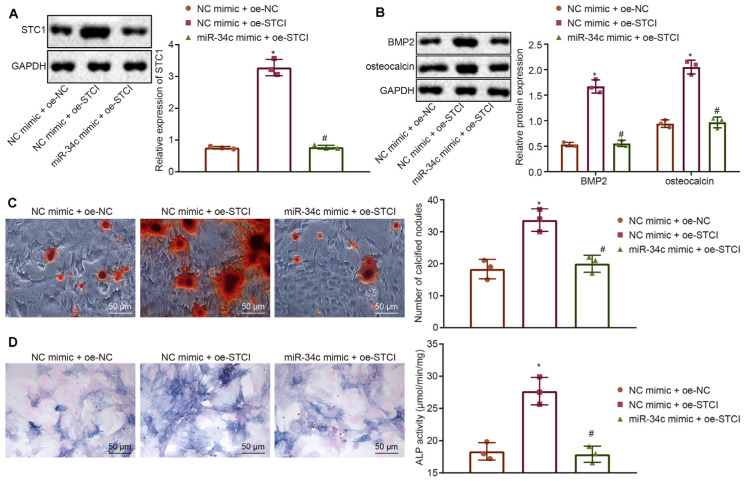
The osteogenic differentiation and calcification degree of VICs is inhibited by miR-34c via suppressing the expression of STC1. VICs were transfected with NC mimic + oe-NC plasmid; NC mimic + oe-STC1; and miR-34c mimic + oe-STC1, respectively. (A) The protein expression of STC1 in VICs with different treatment measured by western blot analysis. (B) The protein expression of BMP2 and osteocalcin determined by western blot analysis. (C) Alizarin red staining (×200) of calcification. (D) The staining figure of ALP (×200) and ALP quantitative activity analysis. Data were expressed as mean ± standard from at least three independent experiments. The comparison between two groups was checked by unpaired Student’s t test. *p < 0.05 vs. VICs transfected with NC mimic + oe-NC. #p < 0.05 vs. VICs transfected with NC mimic + oe-STC1.